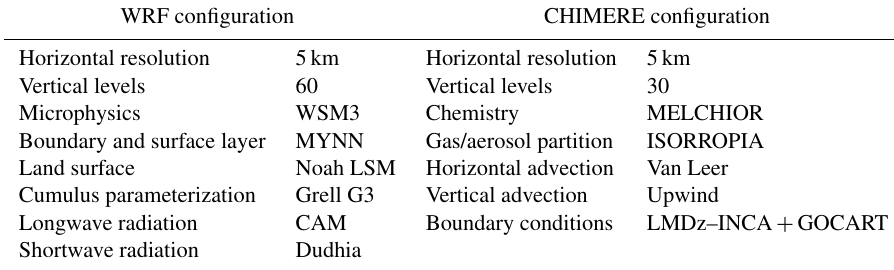
Table A1. WRF and CHIMERE configurations.